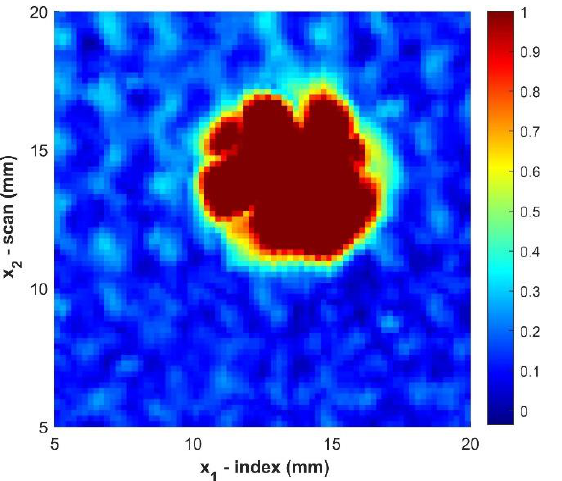
Figure 4. C-Scan of sample B2 prior to any filtering. Color indicates the normalized amplitude of the ultrasonic